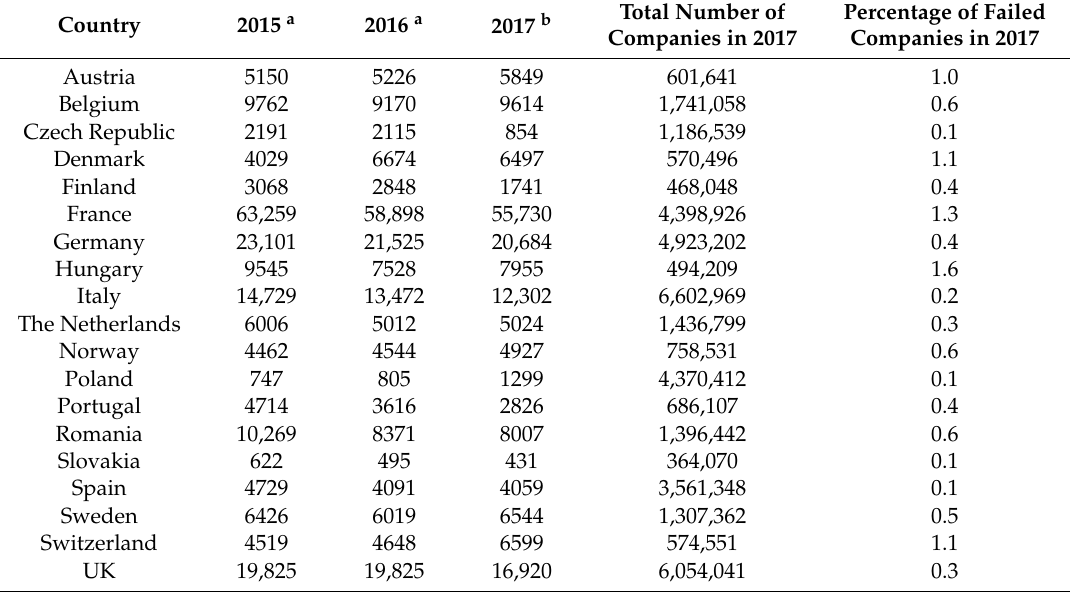
Table 1. The number of insolvencies and failures in selected European countries in 2015–2017 and the percentage of failed companies in